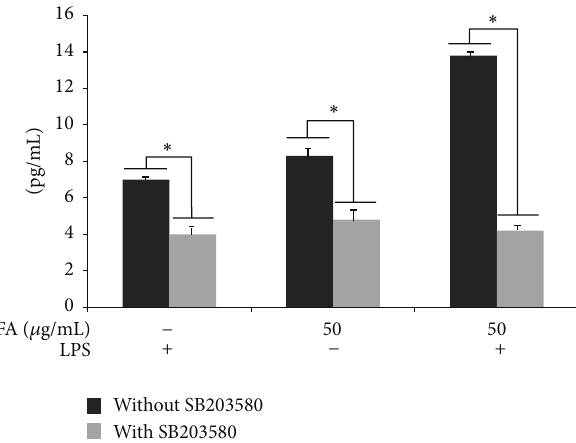
Figure 5: IL-10 production induced by folic acid (50 𝜇 g/mL) activity is downregulated by p38 inhibition. BV-2 cells were incubated with 10 𝜇 M of p38 pharmacological inhibitor, SB203580, 1 hour before LPS treatment in the presence or absence of folic acid. The supernatants were collected after 24h LPS treatment and assayed for IL-10 release. This assay was performed in triplicate and data are expressed as the mean ± SD of five independent experiments. ∗ 𝑝 < 0.05